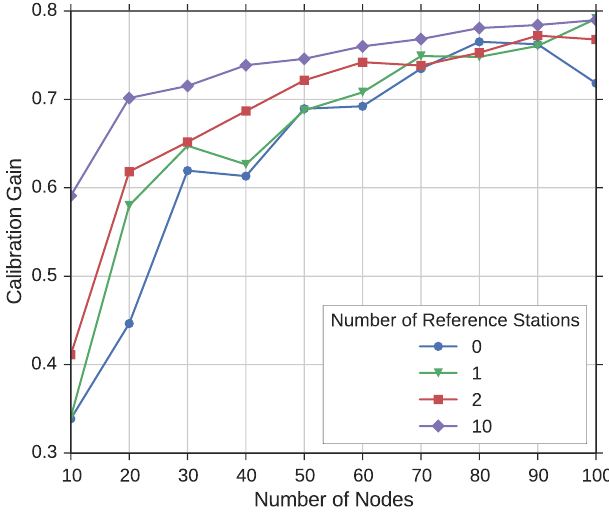
Figure 3. Competitiveness of pure rendezvous-based calibration is shown by impact of reference